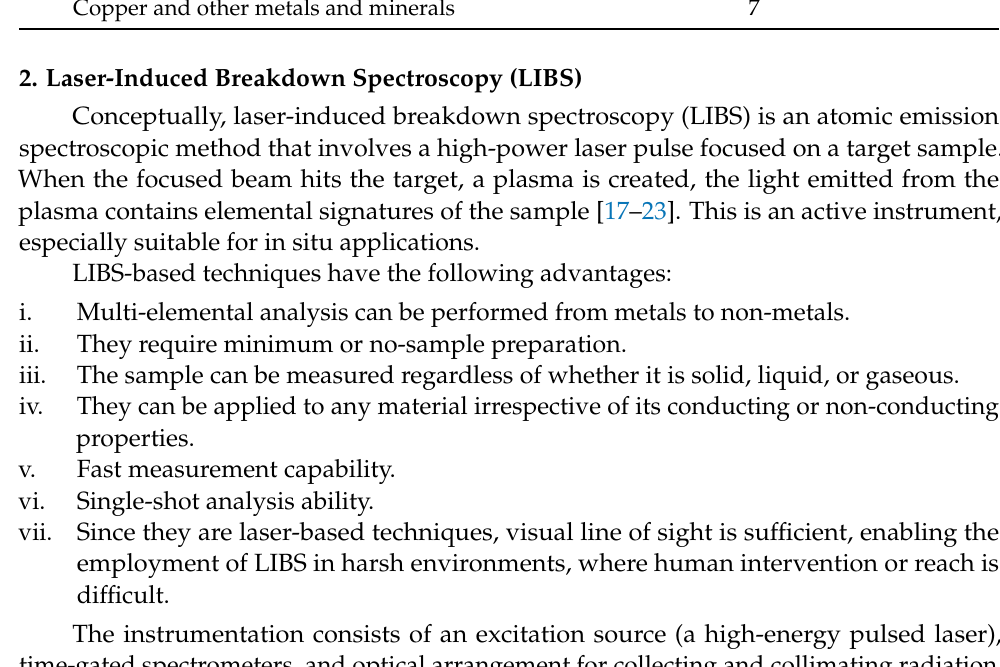
Table 1. Categories of LIBS applications summarized in this review. Categories Count of Papers Aluminum